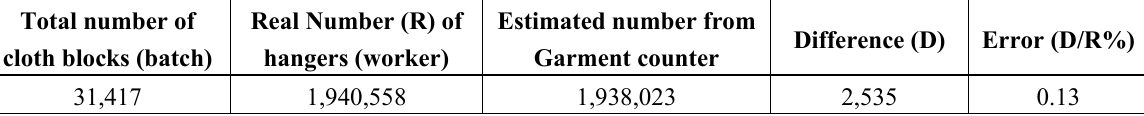
Table 2. Resume of performance evaluation during 41 days (from 10 February to 15